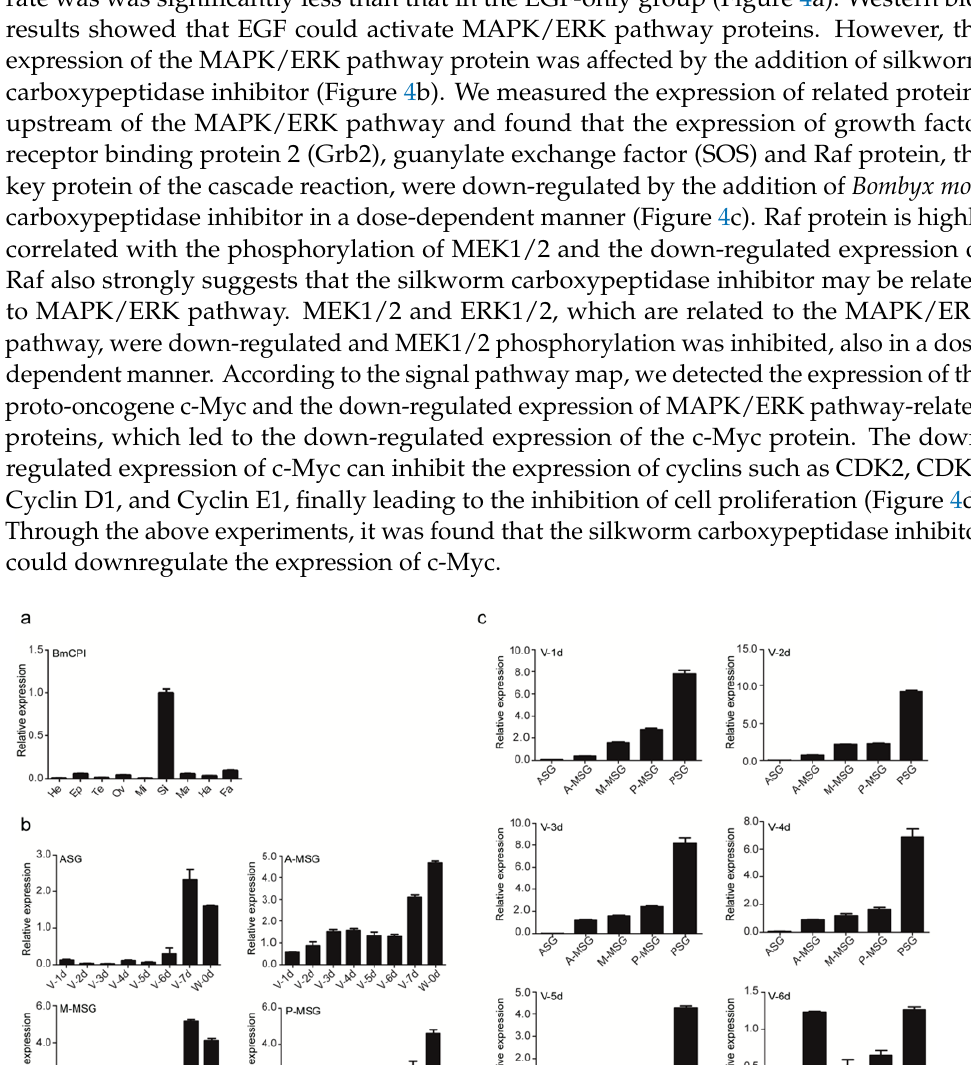
Figure 2. Bombyx mori carboxypeptidase inhibitors are specifically and highly expressed in silk glands. ( a ) Quantitative PCR results showed that the carboxypeptidase inhibitor was specifically and highly expressed in silk glands of Bombyx mori . ( b ) Expression of carboxypeptidase inhibitors in each segment of silkworm fifth instar silk gland. ( c ) Expression of carboxypeptidase inhibitors in silk glands at different stages (early and late) of fifth instar silkworms. Abbreviations: He, head; Ep, epidermis; Te, testis; Ov, ovary; Mi, midgut; Si, silk gland; Ma, Malpighian tube; Ha, hemocytes; Fa, fat body; ASG, anterior silk gland; A-MSG, anterior area of the middle silk gland; M-MSG, middle area of the middle silk gland; P-MSG, posterior area of the middle silk gland; PSG, posterior silk gland, V-1d, first day of the fifth instar; W-0d, the